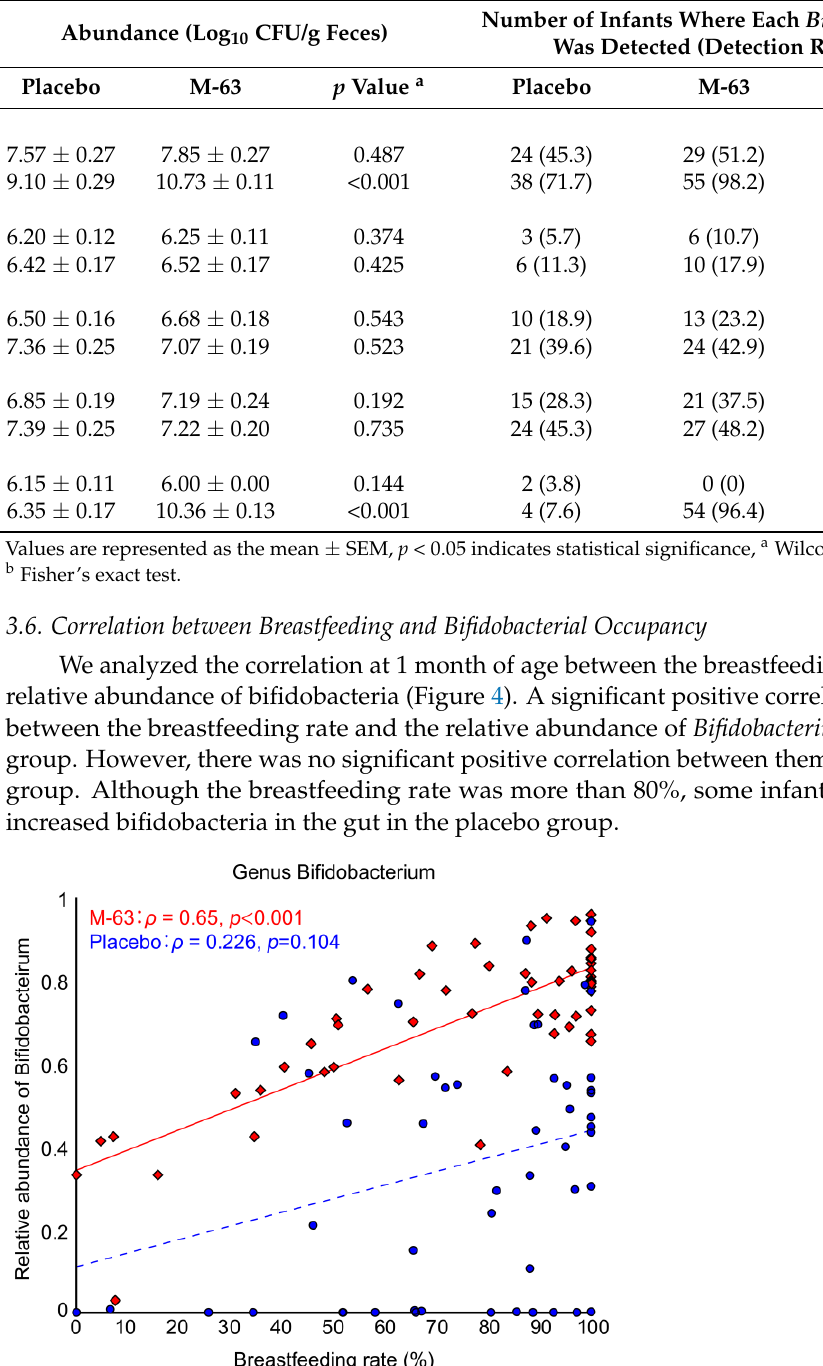
Table 3. Abundance and detection rate of Bifidobacterium species.